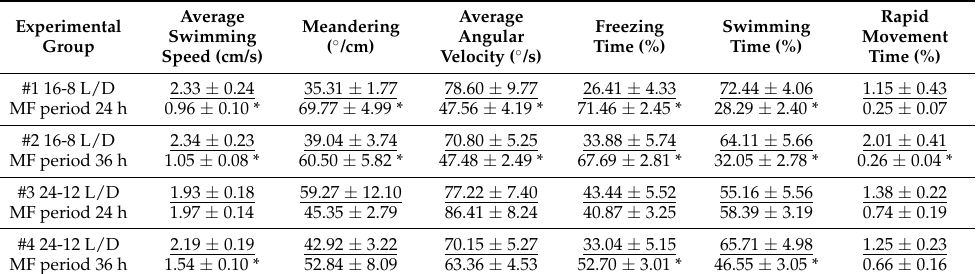
Table 1. Studied behavioral endpoints in zebrafish at the light and dark phases during the first stage of